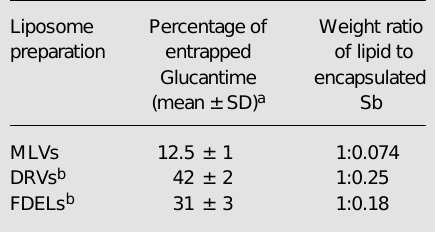
Table 2 - The effect of liposome-encapsulated meglumine antimoniate (Lglu, 60 mg Sb/kg), free meglumine antimoniate (Glu, 100 mg Sb/kg) and empty liposomes (Lemp) on L. chagasi parasite burdens of liver and spleen in